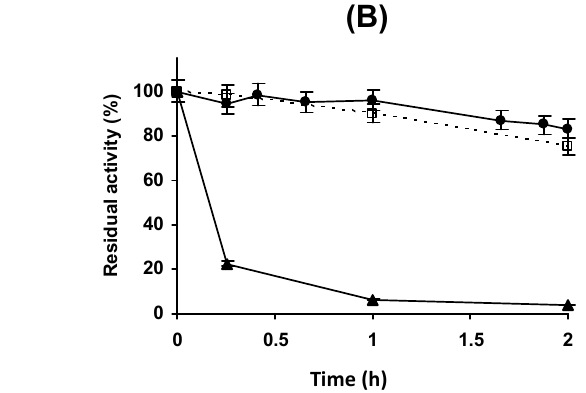
Figure 10. Immobilization of r Aae UPO on MANAE support at 25 °C and ( A ) pH 5.0 or ( B ) pH 9.0. Other specifications can be found in the Methods section. Full circles: suspension; full triangles: supernatant; empty squares with dotted line: reference.